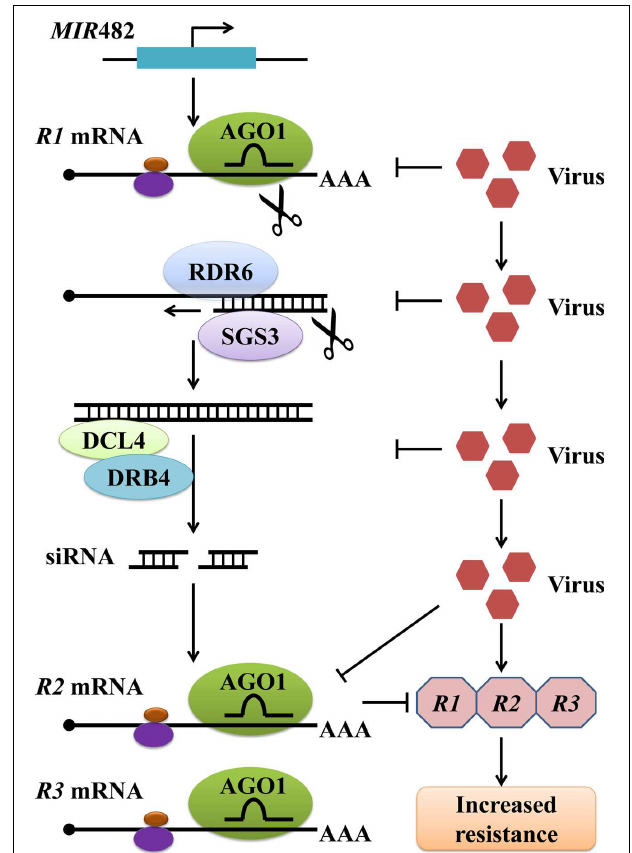
FIGURE 2 | A pathway of plant miRNA482-mediated resistance against virus by inducing the production of siRNAs responsible for regulating R genes. The expression of MIR 482 triggers the simultaneous silencing of multiple R genes through tasiRNAs produced from dsRNA derived from a primary miR482-targeted R gene. Virus infection may trigger silencing suppression involved in this process at several steps, resulting in increased accumulation of multiple R proteins and enhanced resistance. AGO1, Argonaute 1; DCL4, Dicer-like 4; RDR6, RNA-dependent RNA polymerase 6; SGS3, Suppressor of gene silencing 3; DRB4, Double-stranded RNA binding protein